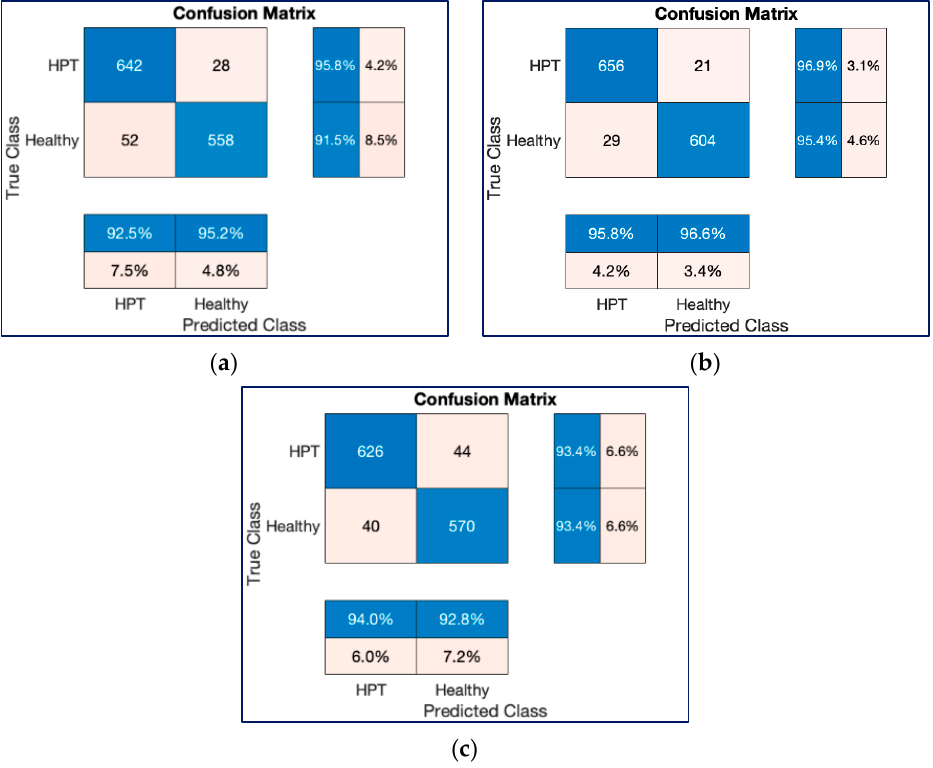
Figure 13. Confusion chart results for classification process with 12,800 spectrogram images in a trial on the 10 ‐ FCV. ( a ) ResNet18, ( b ) ResNet50, ( c ) ConvMixer.